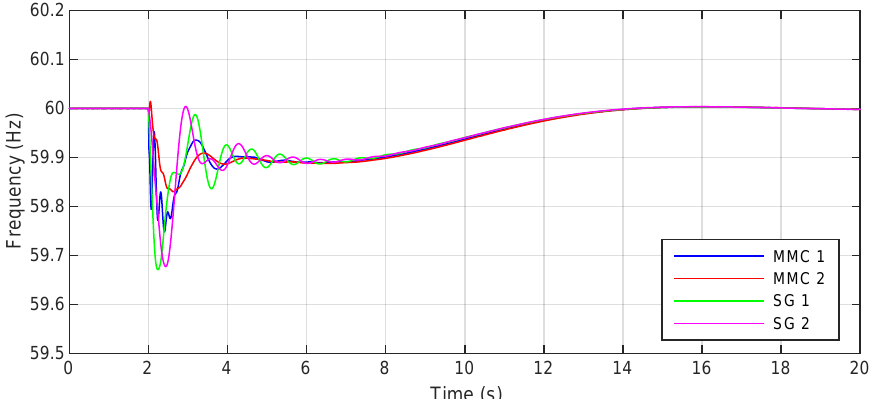
Figure 11. Frequency behavior of the elements of the test system after disturbance in Scenario 2. The frequency and power behavior of the converters connected into the system repre- senting the HVDC systems are shown in Figures 12 and 13, respectively. They both injected power into the grid while their frequency was reduced to counteract the disturbance.